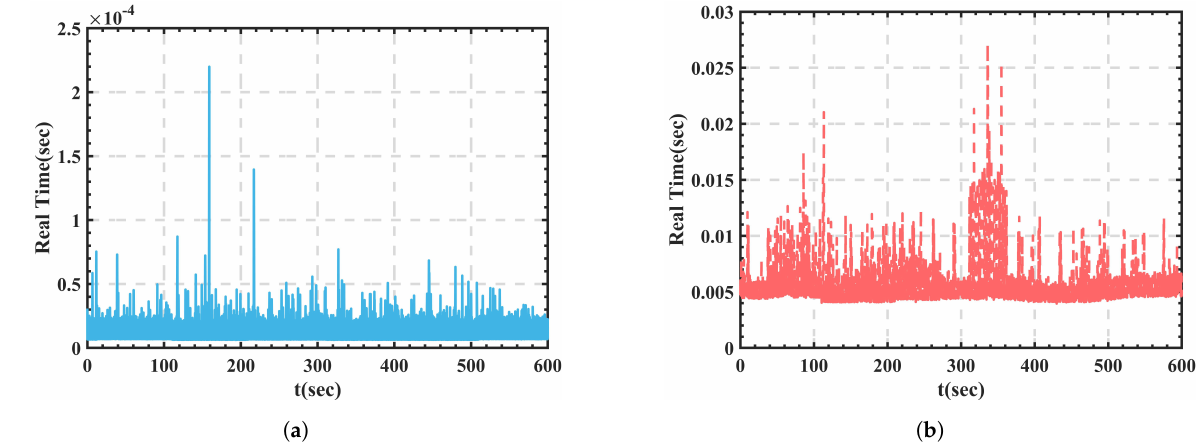
Figure 21. When n y = 9, at each sampling time: ( a ) mpQP-eMPC calculation time; ( b ) tMPC calculation